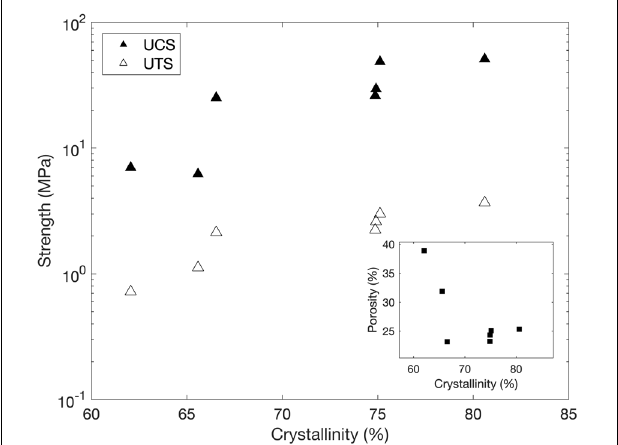
FIGURE 11 | Rock strength as a function of crystallinity, where solid markers show uniaxial compressive strength (UCS) and hollow markers show tensile strength (UTS). Inset shows correlation between crystallinity and